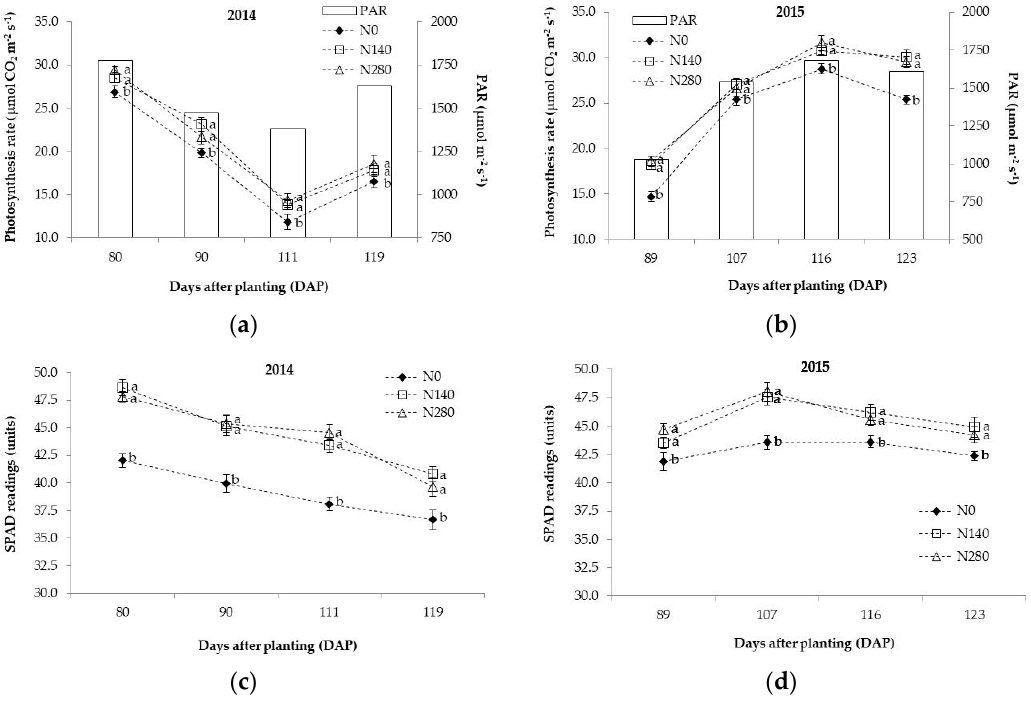
Figure 1. Photosynthesis rate and SPAD readings of early potato leaves as affected by ‘N fertilization rate x measurement data’ interaction. Different letters within each measurement time (expressed as day after planting, DAP) indicate statistically significant differences among the N fertilization rates (least significant difference (LSD) test, p < 0.05).